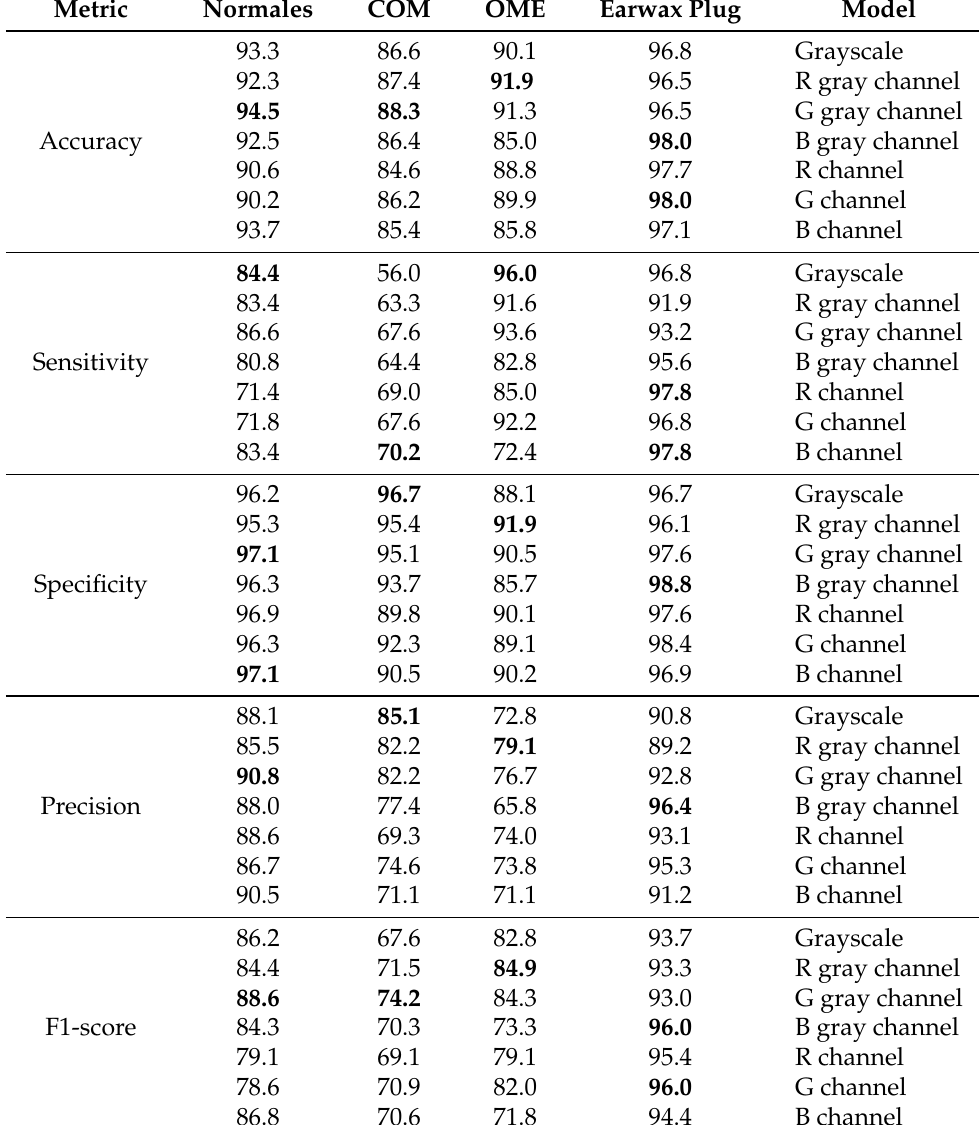
Table 1. System performance comparison per class (diagnosis) using testing